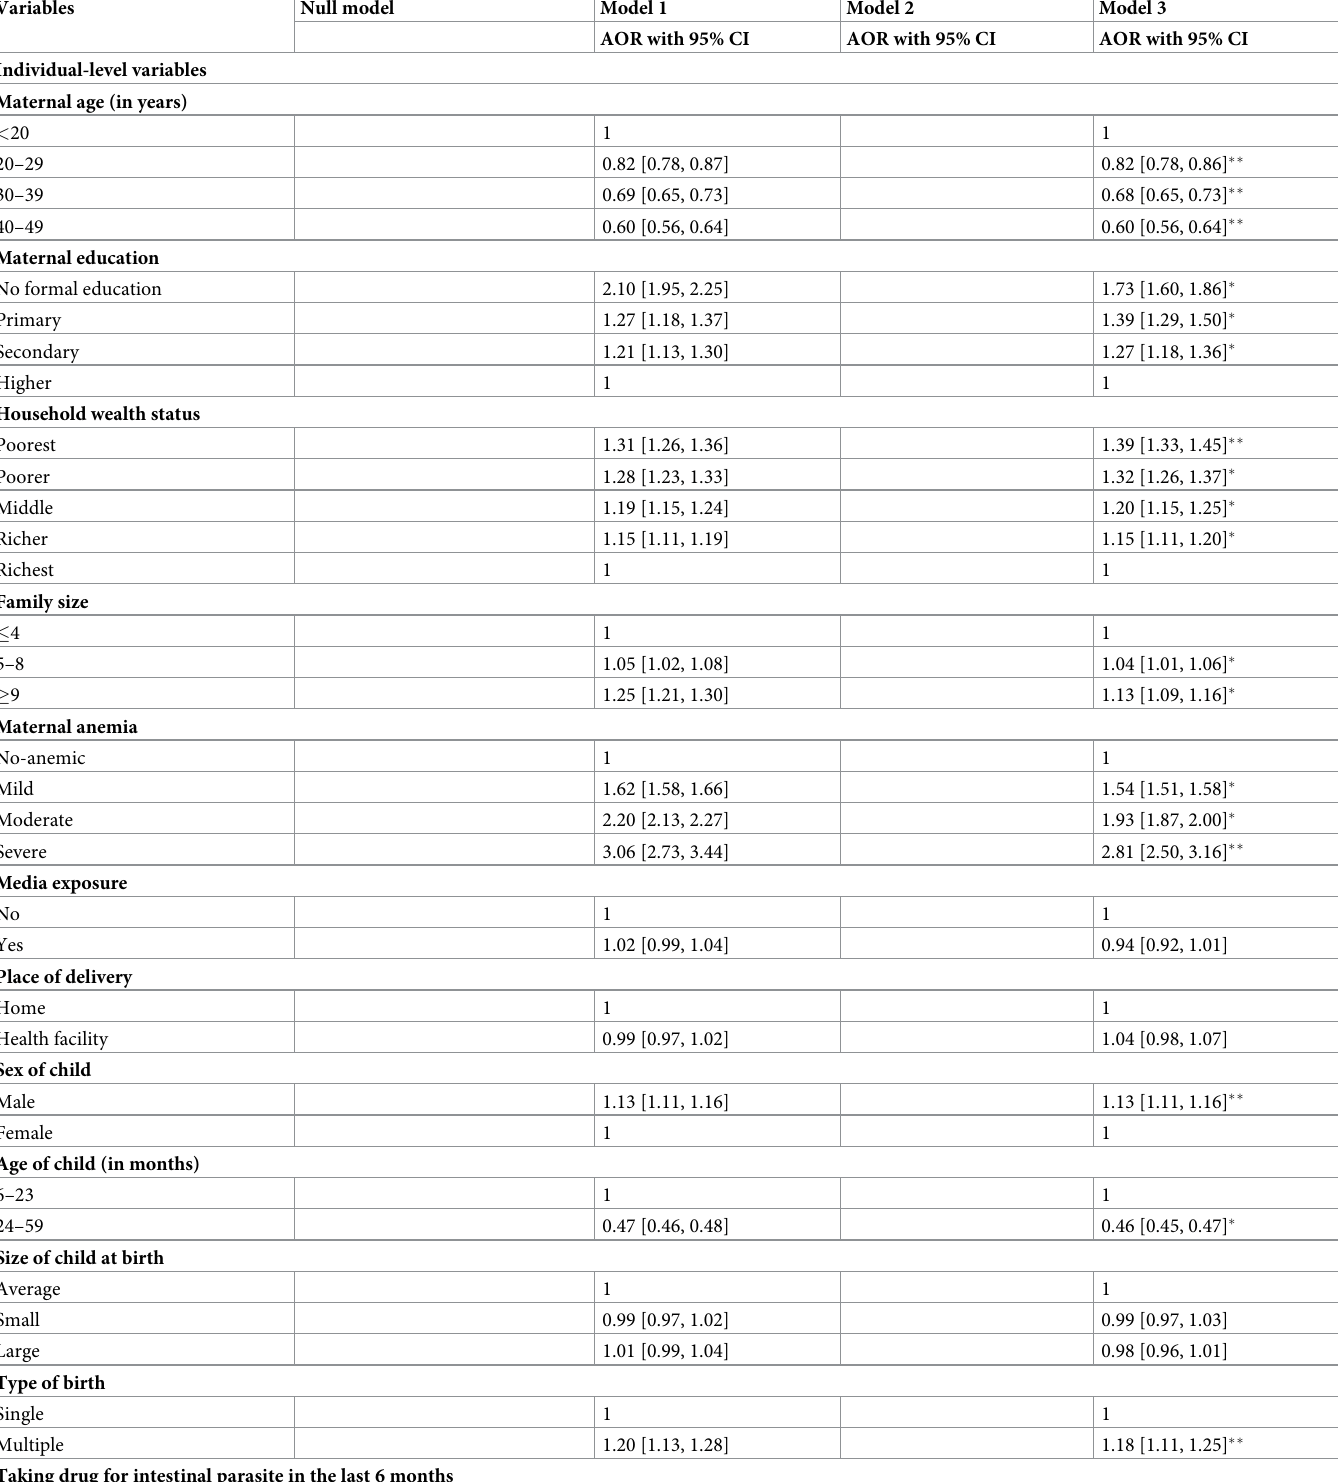
Table 4. Individual and community-level factors associated with anemia among children aged 6–59 months in sub-Saharan